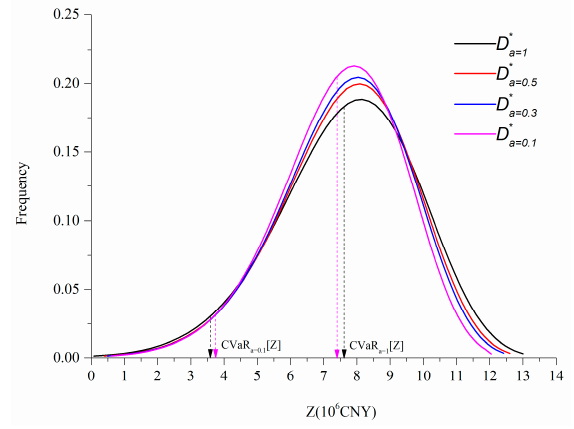
Figure 5. Probability density functions of Z under different values of α ( σ = 40 × 10 6 m 3 ).